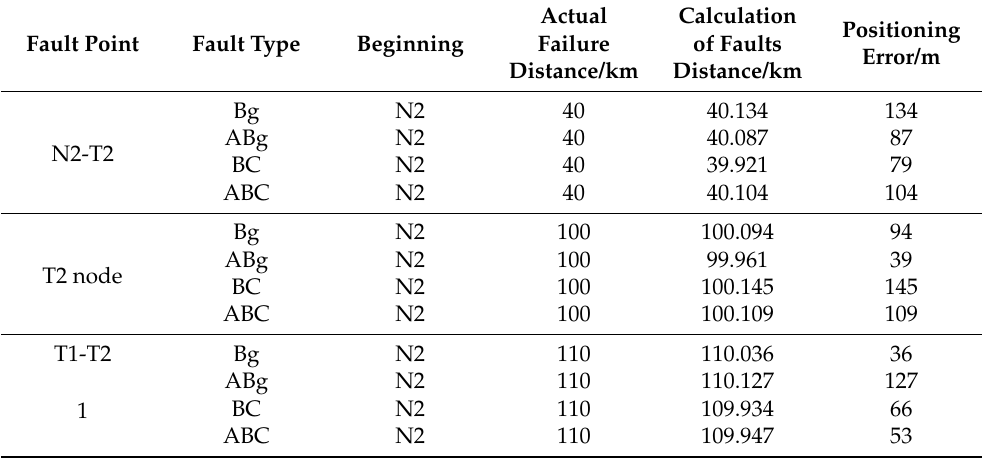
Table 7. The results of the method presented in this paper are obtained under different experimental